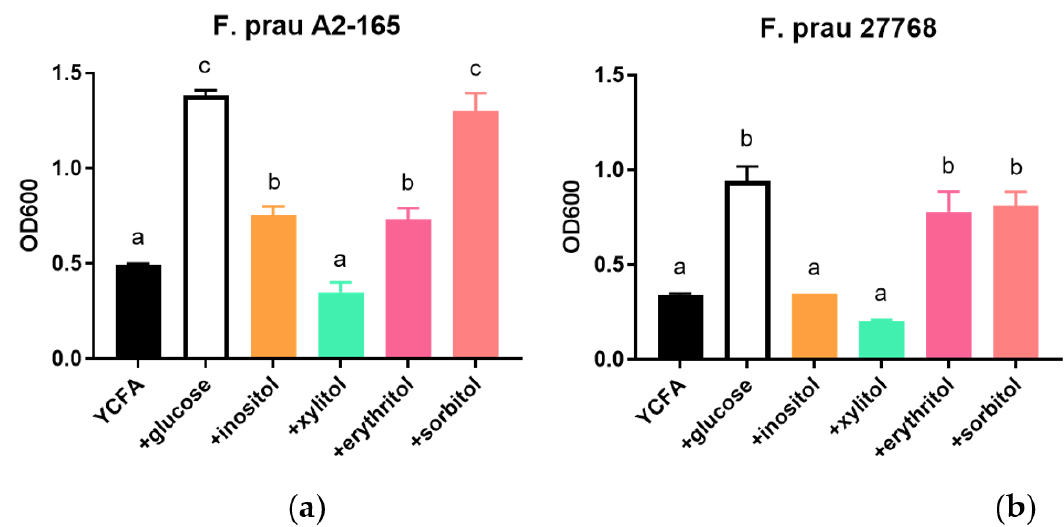
Figure 2. Growth promoting effects of sugar alcohols in two strains of F. prausnitzii . Experiments were performed with DSMZ A2-165 ( a ) or ATCC 27768 ( b ) in a YCFA-based media supplemented with different carbon substrates for 48 h in an anaerobic condition. Results are mean ± SEM, n = 3. Statistical analysis was performed with ANOVA followed by Tukey post hoc analysis. When treatment groups share a same letter, it means no statistical difference between the groups.